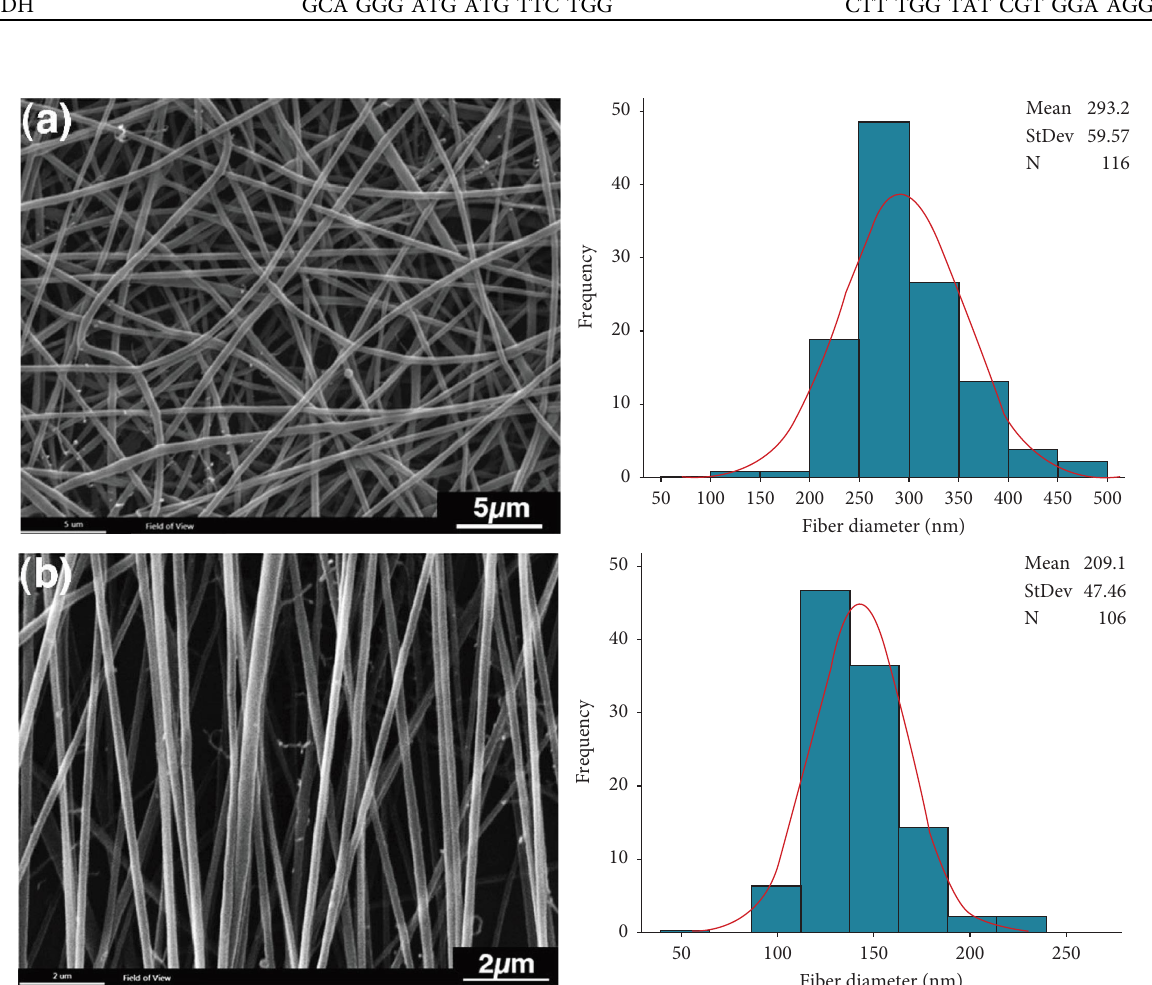
Figure 3: SEM images and the histogram of the fber diameter distribution with the curve of normal-log distribution of the electrospun scafolds: (a) random scafold (R-30) and (b) aligned scafold (A-30).